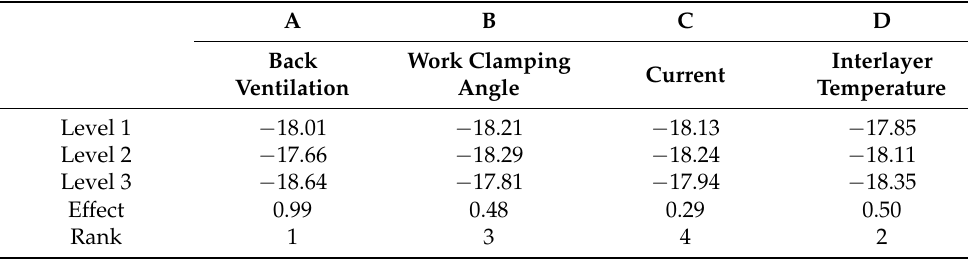
Table 8. S / N ratio factor response table of α -Fe content of UNS31803 duplex stainless steel in L9 direct cross table.